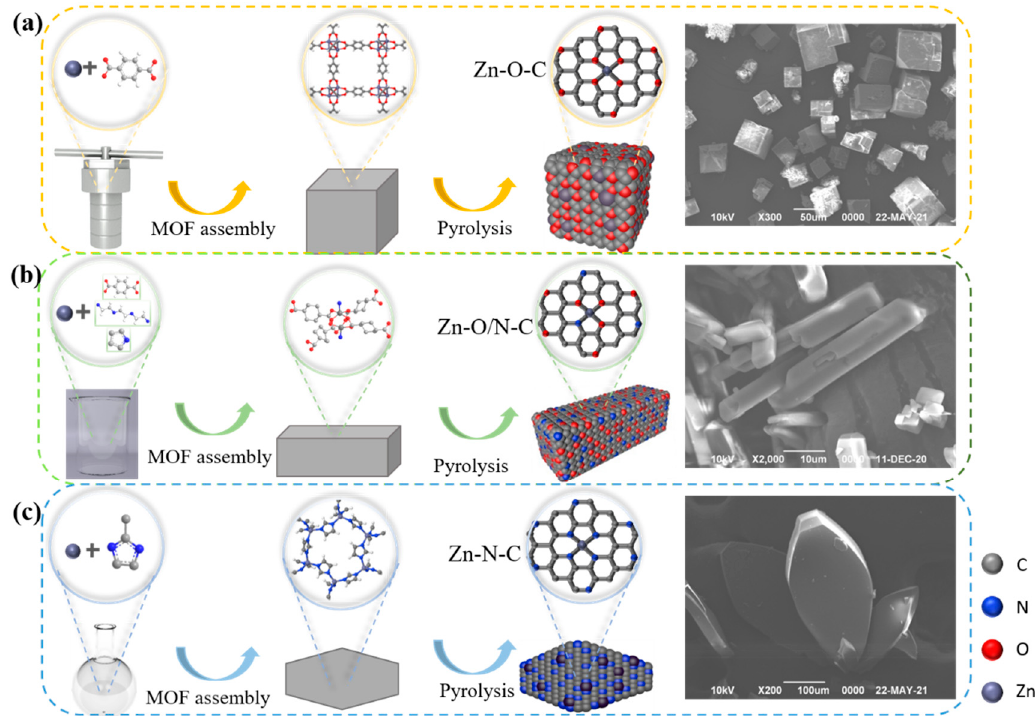
Figure 3. Schematic diagrams of the synthesis process and the SEM images of MOF5 ( a ), TEDA-PD ( b ), and ZIF8 ( c ), respectively.